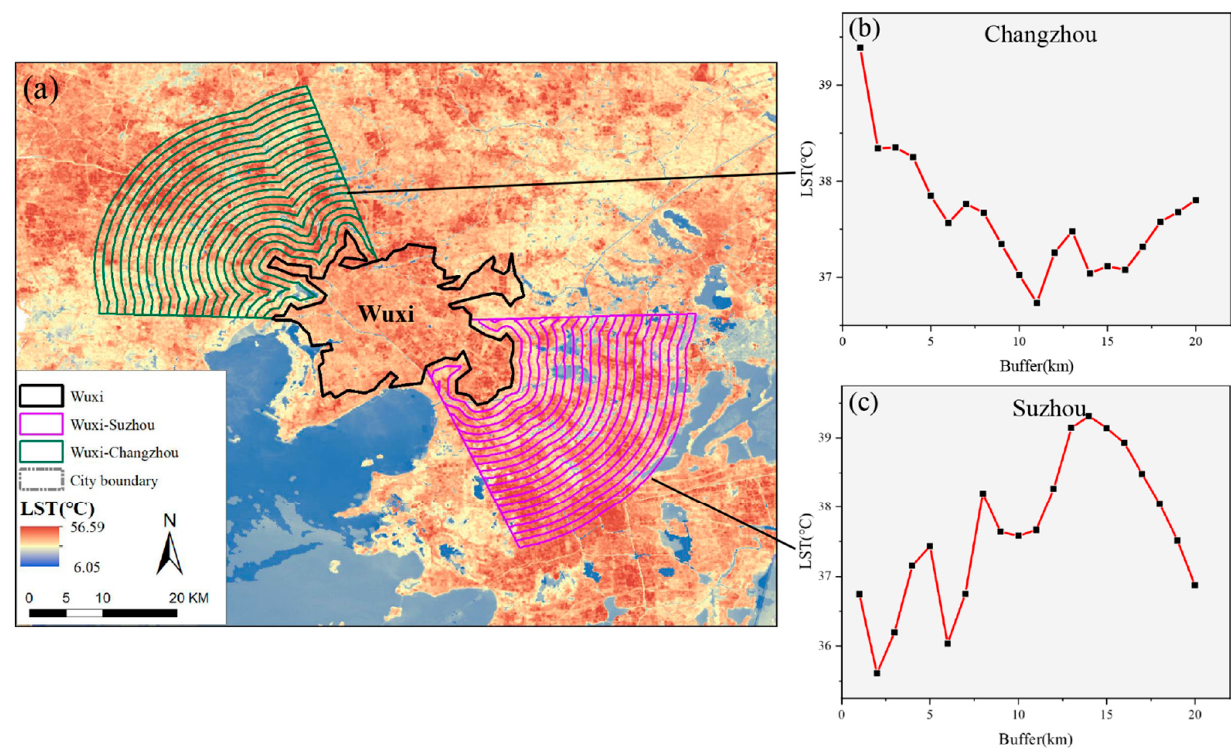
Figure 12. The surface urban heat island coupling effect in the Su-Xi-Chang metropolitan area. ( a ) The sector where the urban heat island coupling effect between Wuxi and Changzhou and between Wuxi and Suzhou occurs; ( b ) land surface temperature curve between Wuxi and Changzhou; ( c ) land surface temperature curve between Wuxi and